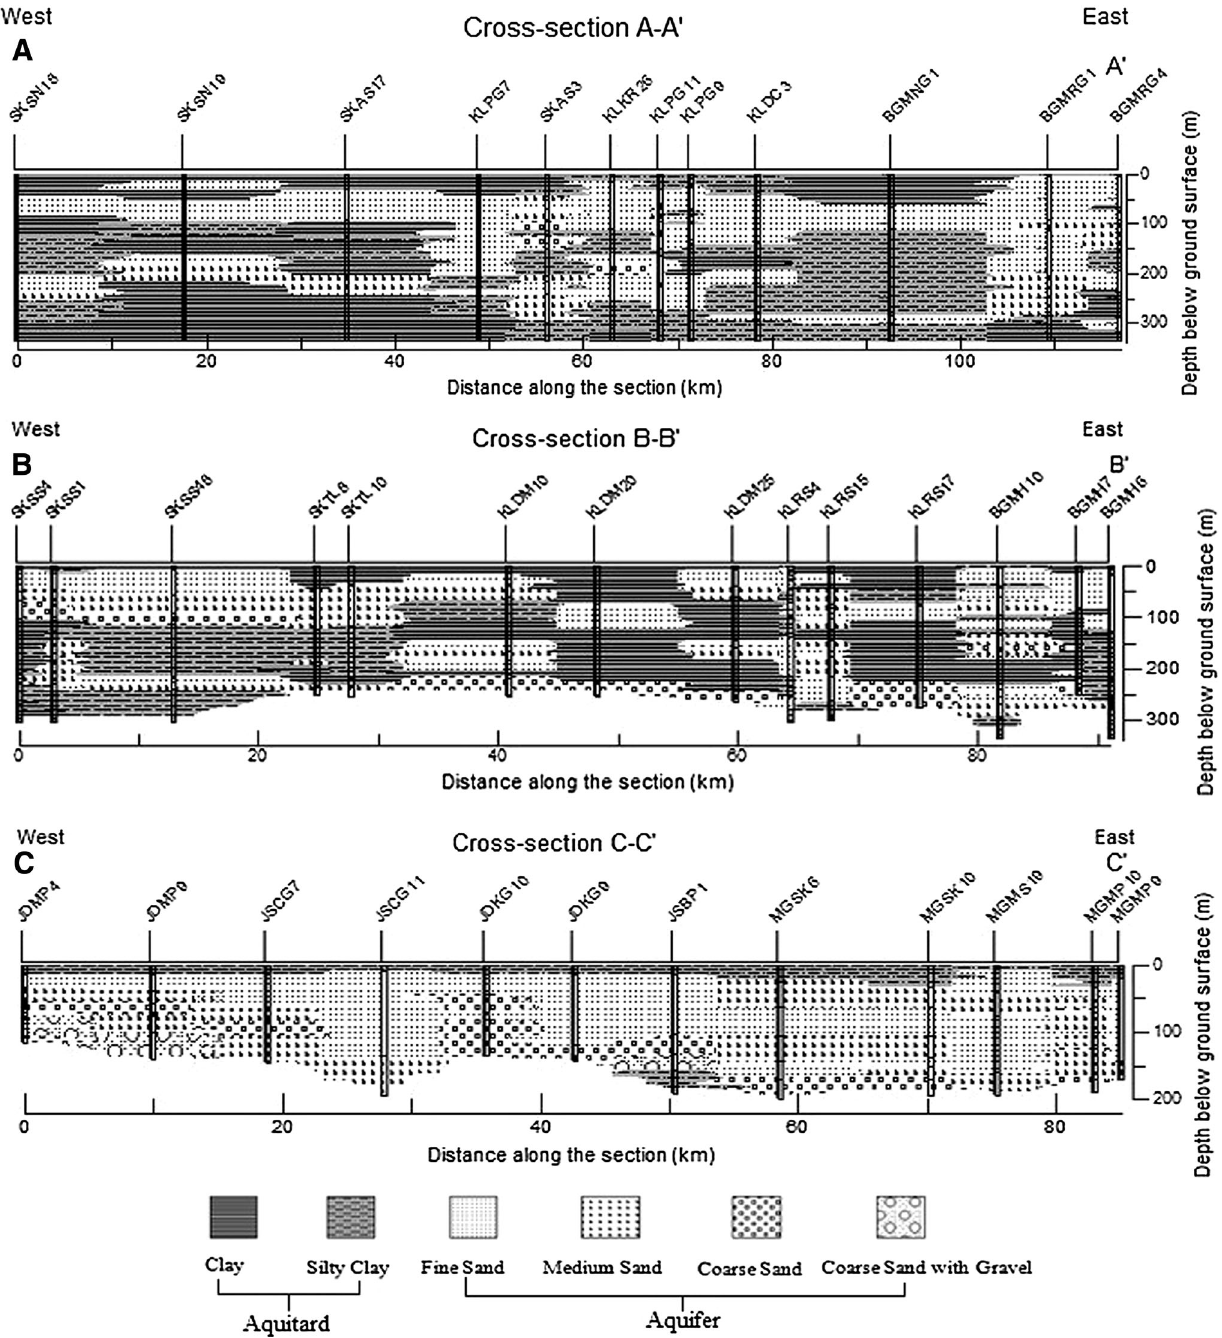
Fig. 5 EW cross sections along AA 0 , BB 0 , and CC 0